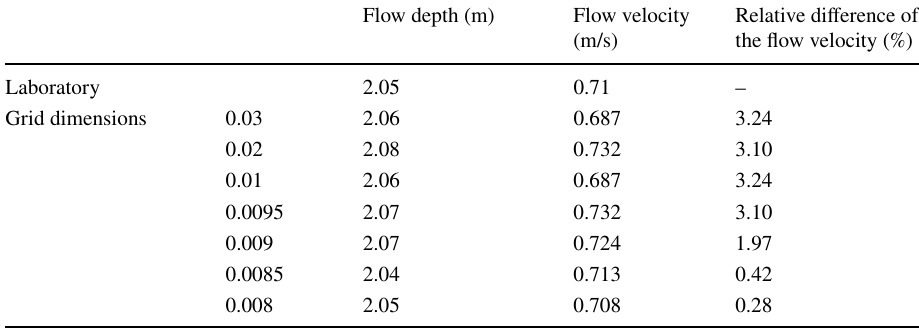
Table 1 Sensitivity analysis on grid dimensions in section